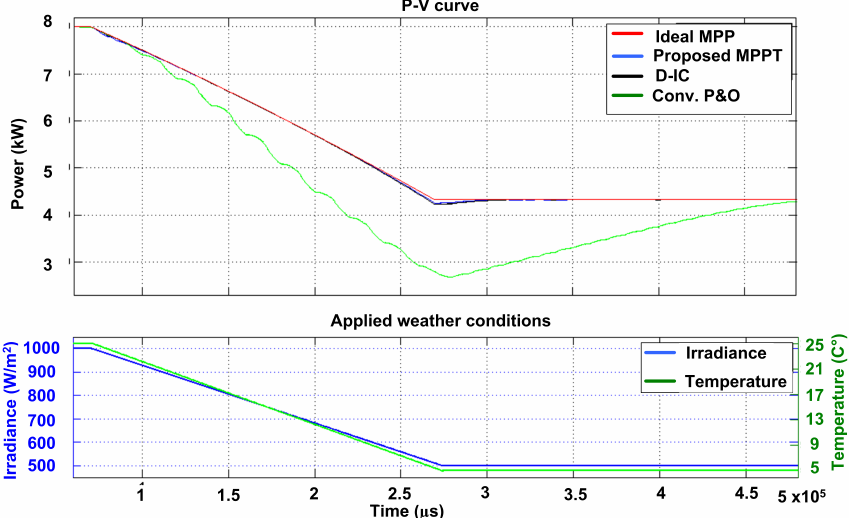
Figure 13. Case 4: Response of three algorithms under linear decay in weather conditions.